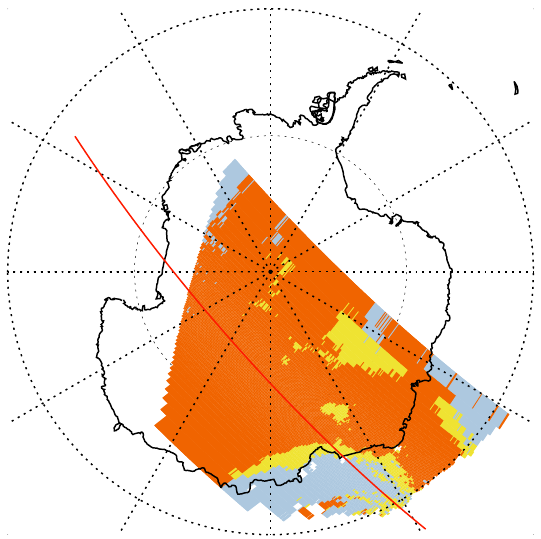
Fig. 8. As in Fig. 7 but for OMI orbit 12395.